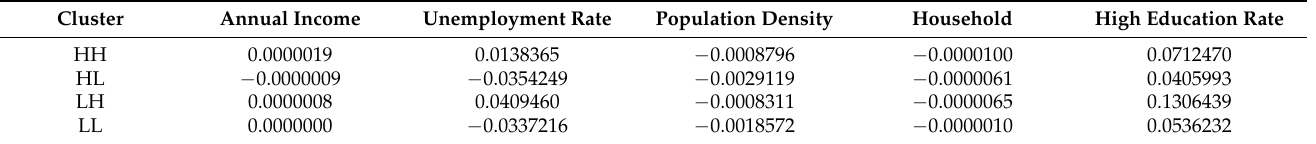
Table 7. Mean coefficient values measured at the district level in relation to childhood obesity clusters in